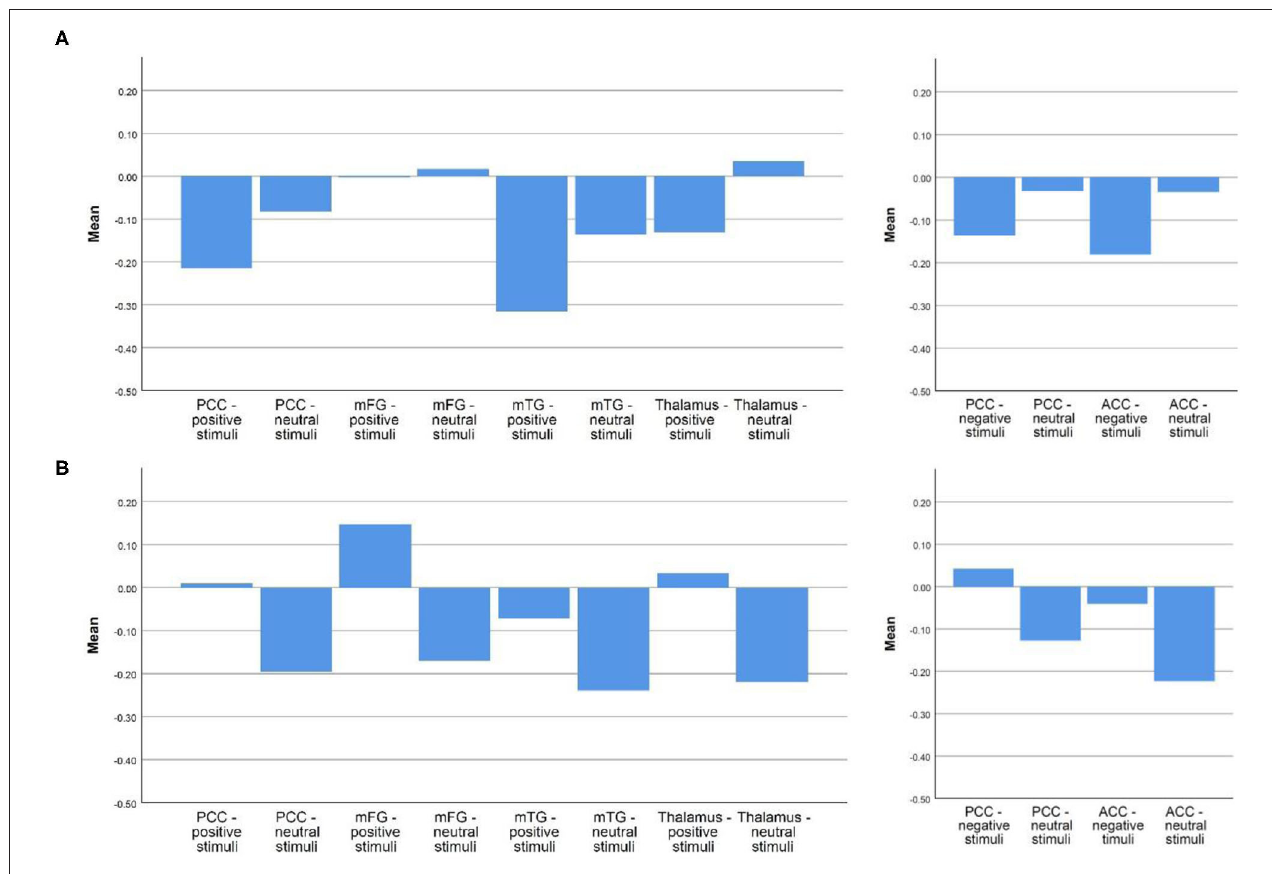
FIGURE 4 | Mean betas in responders and non-responders in each region of interest during the perception of emotional vs. neutral stimuli. (A) Non-responder; (B) Responder. Depicted are the mean betas of responders and non-responders in our regions of interest in the respective emotional and neutral condition, the two graphs on the left site concern the regions more active in responders during the perception of positive stimuli, the two graphs on the right the ones more active in responders during the perception of negative